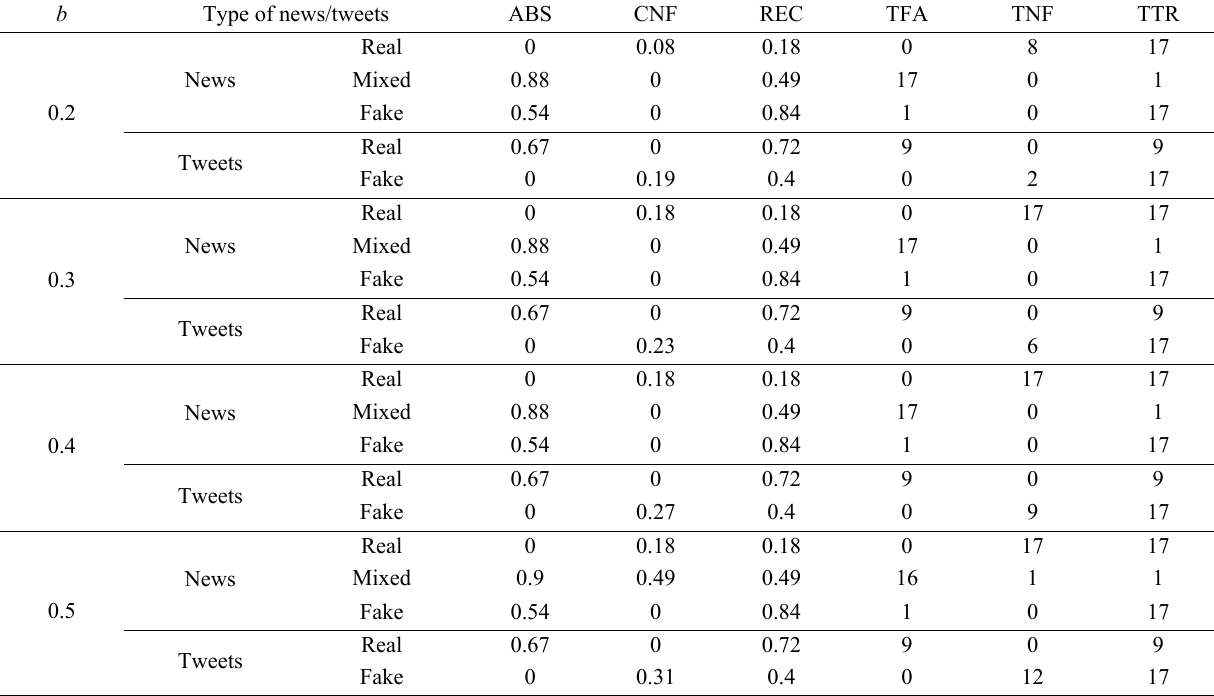
Table 8 Absorption (ABS), community non-functioning (CNF), recovery (REC), time for absorption (TFA), time under community non-functioning (TNF), and time to recovery (TTR) for news and tweets with the critical resource distribution functionality threshold b varying over the range of 0.2–0.5.